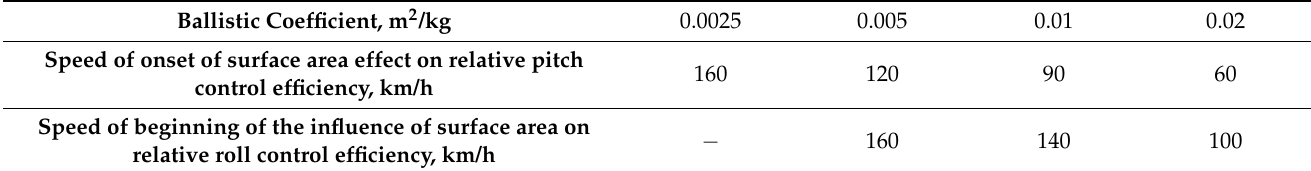
Table 2. Parameters of cargo and flight speed, at which the influence of the surface area of the cargo was